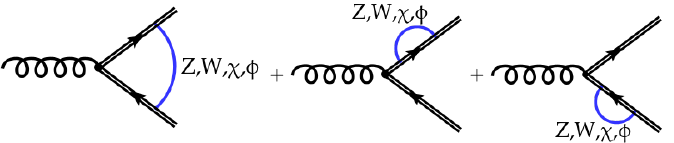
Figure 2 . Final state corrections with EFT contributions to the s -channel q (cid:22) q and gg processes.